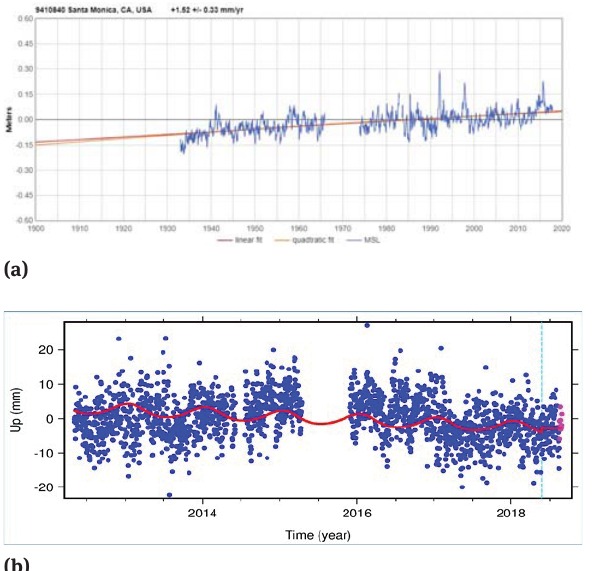
Figure 18: (a) MSL data for Santa Monica, CA, USA. Image repro- duced modified after [4]. (b) GNSS time series for CASM. Image reproduced modified after NGL.